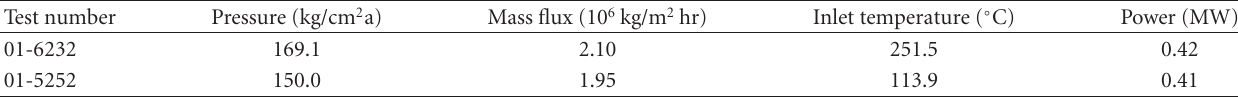
Table 3: Test parameters for temperature measurements.